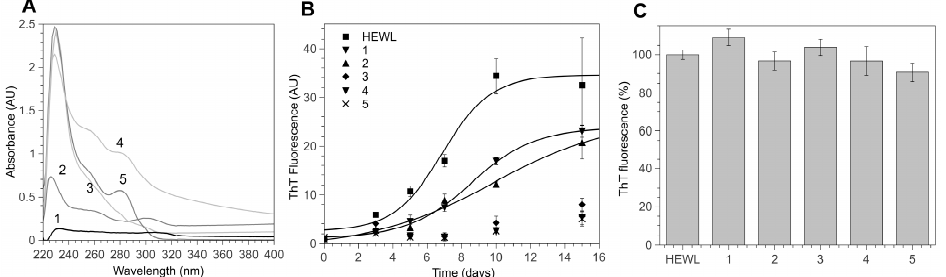
Figure 2. 4 ‐ Thiaflavane derivatives inhibit hen egg ‐ white lysozyme (HEWL) amyloid